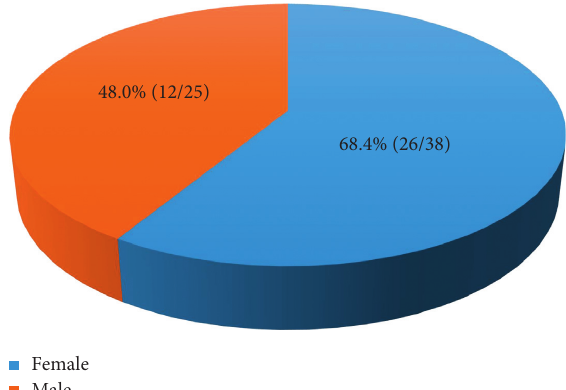
Figure 3: Sex distribution of triple Pfdhfr mutant alleles 51I, 59R, and 108N ( p < 0 .